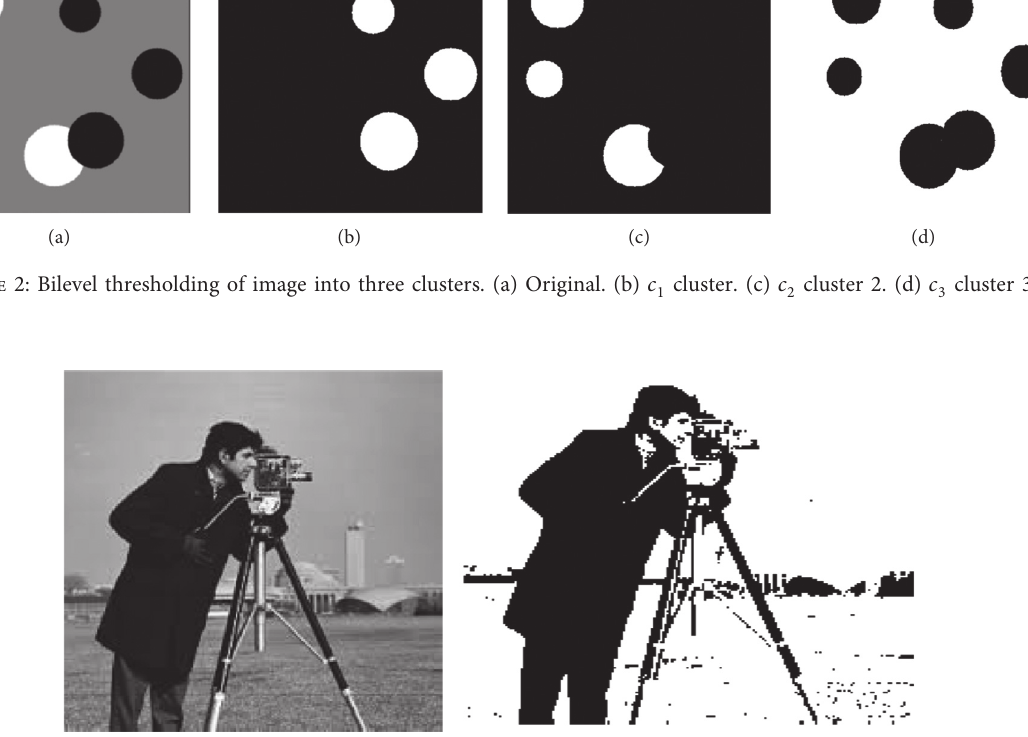
Figure 3: A binarized image using proposed global